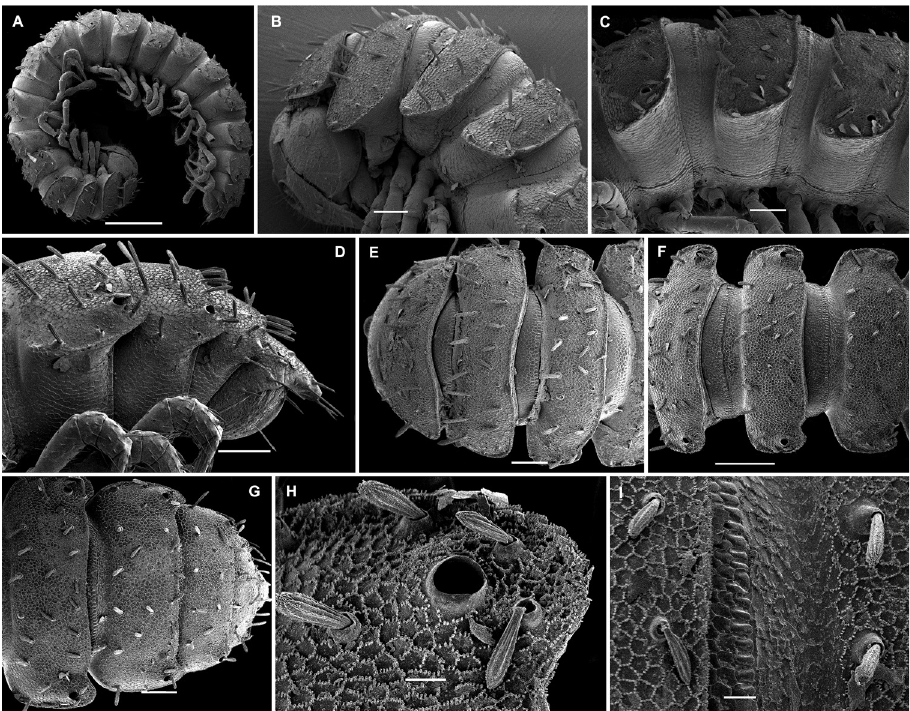
Figure 7. Hemisphaeroparia spiniger sp. n., SEM micrographs of ♂ paratype A habitus, lateral view B, E anterior part of body, lateral and dorsal views, respectively C, F midbody segments, lateral and dorsal views, respectively D, G posterior part of body, lateral and dorsal views, respectively H midbody parater- gum, dorsolateral view I tergal fine structure. Scale bars: 0.5 mm ( A ), 0.1 mm ( B–G, J ), 0.02 mm ( H, I